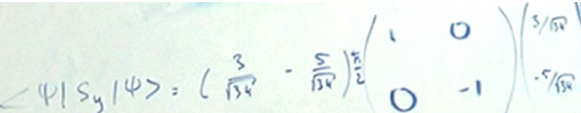
FIG. 2. Mark ’ s expectation value calculation where he ex- pressed everything in the y -basis